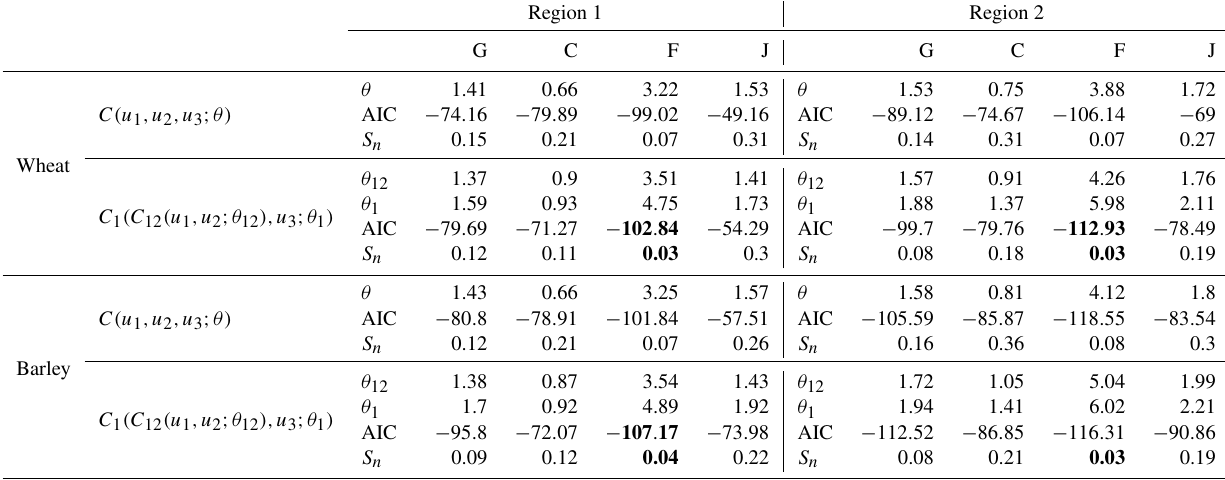
Table 2. Trivariate Archimedean copula (AC) parameters ( θ ) with nested structure with two-parameter C 1 (C 12 (u 1 ,u 2 ; θ 12 ),u 3 ; θ 1 ) and with one-parameter C(u 1 ,u 2 ,u 3 ; θ) and respective Akaike’s information criterion (AIC) and Cramér–von Mises distance ( S n ). Fit based on maximum pseudo-likelihood (Gumbel, G; Clayton, C; Frank, F; and Joe, J, copulas). Smaller values of AIC and S n indicate the selected copula for each cereal and region